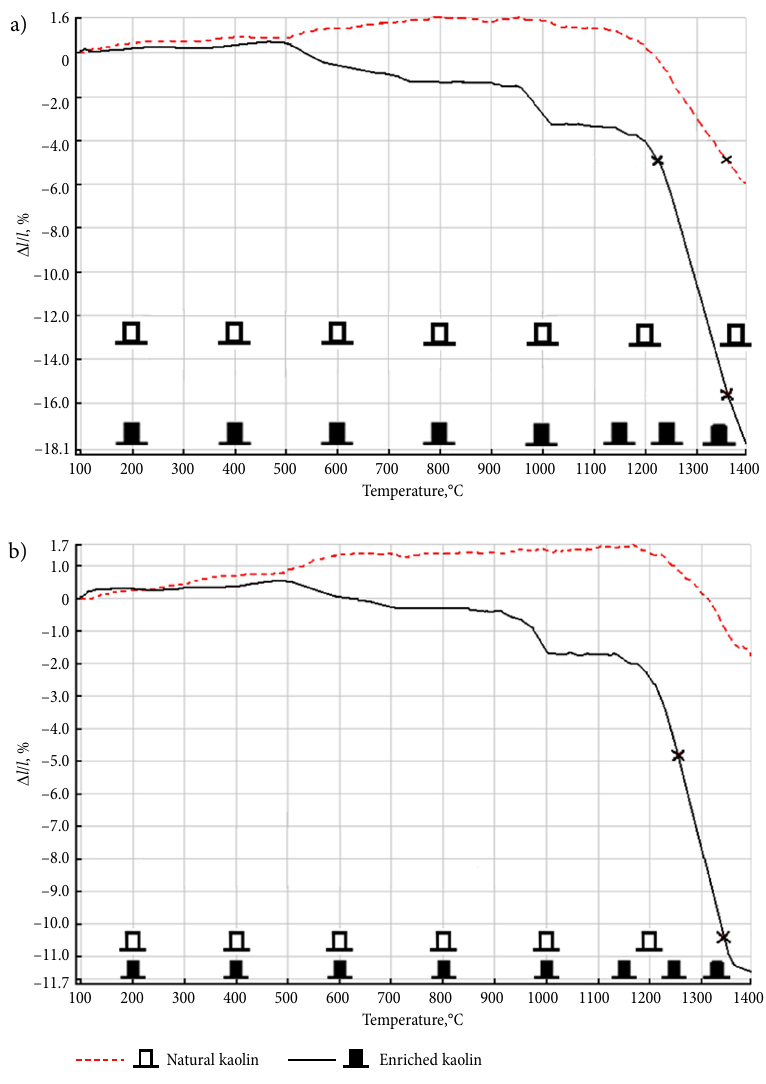
Fig. 2. The dilatometric curves of kaolin of “Sitnitsa” (a) and “Dedovka” (b)